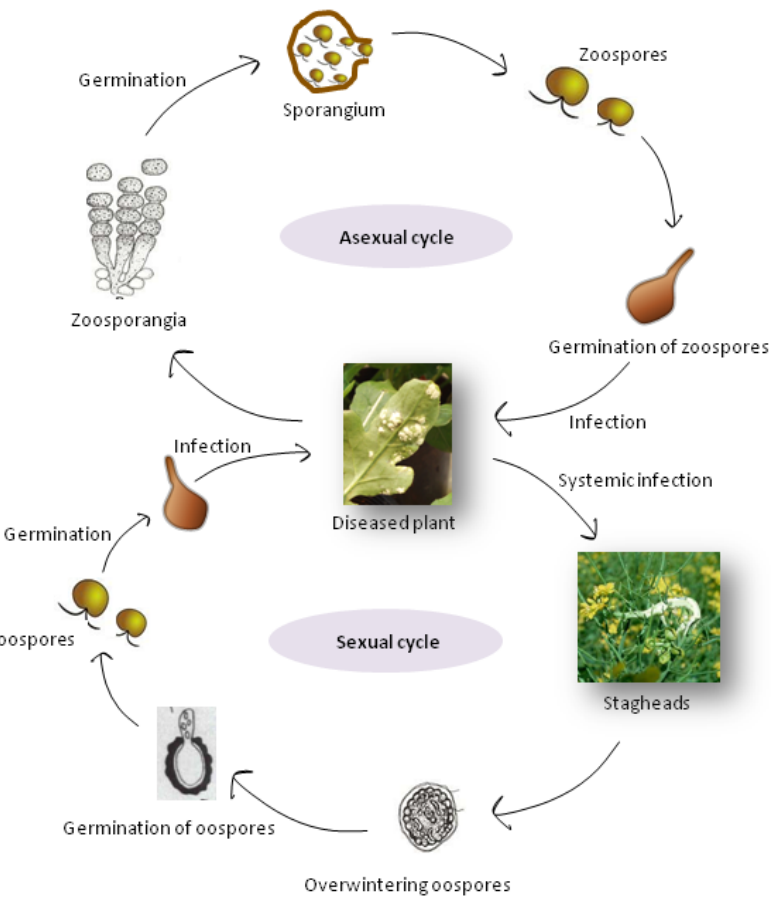
Figure 1. Life cycle of Albugo candida (adapted from Saharan and Verma, 1992). Reproduced with the permission of the publisher,